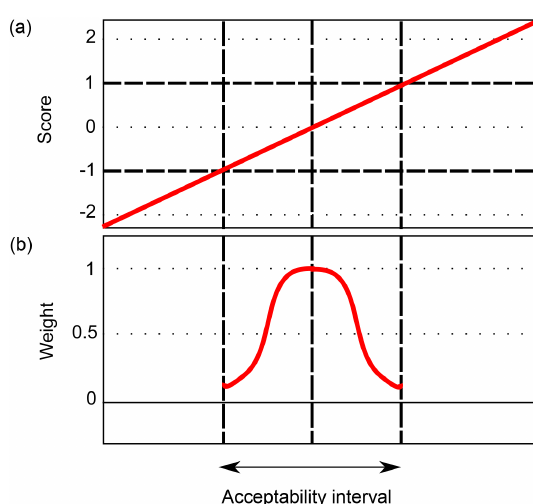
for prediction, each accepted model was given a likelihood weight according to how well it has performed for each of the 964 evaluation criteria. Here the statistical deviation weight was used (truncated to 90 % prediction interval) (Fig. 6b). To “combine” the weights derived from the rating curve and the SRP concentration statistical models, a kernel density esti- mate (with Gaussian smoothing kernel) was computed to fit 10 000 realizations of the multiplied error models. Calculated weights were then averaged for discharge, baseflow SRP load and storm SRP load respectively, and the final likelihood was calculated as the product of all three